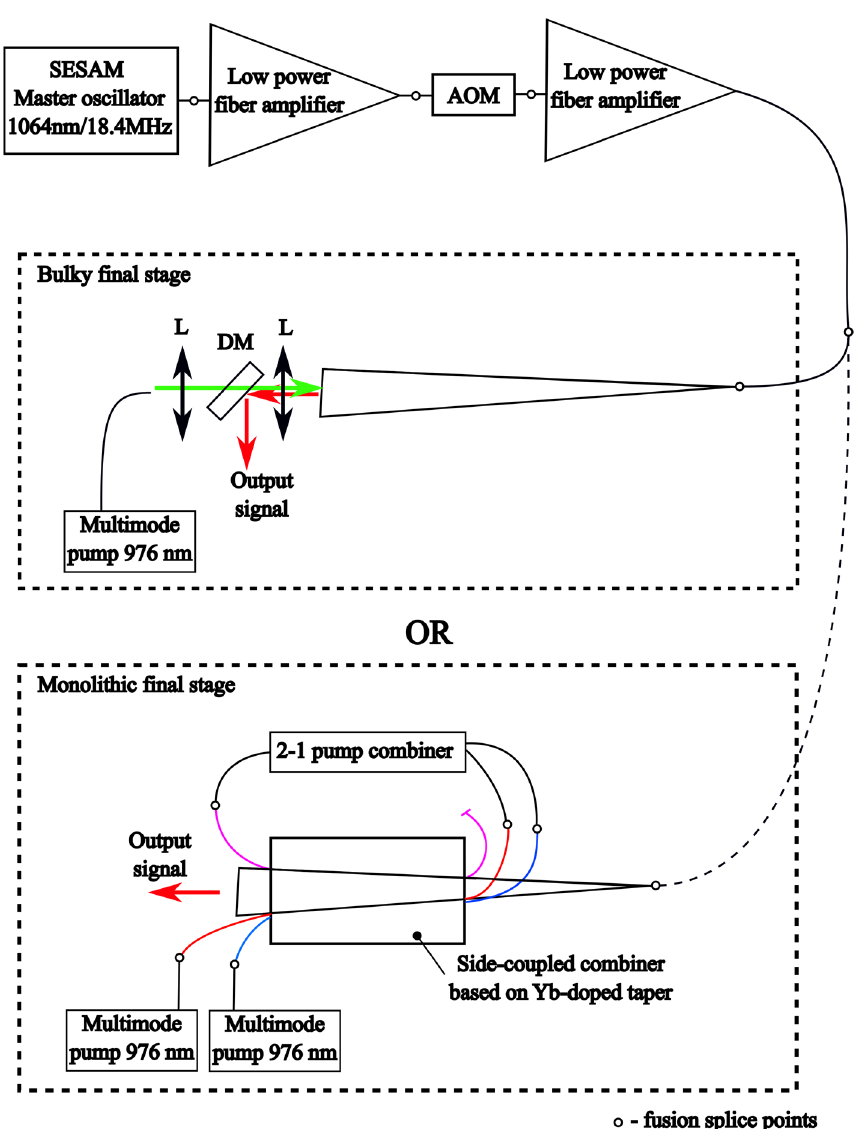
Figure 5. The realized all-fiber MOPA, both bulky and monolithic final stages are shown. Low-power pulses were generated in SESAM master oscillator, amplified at mW level in the low-power fiber amplifiers, and then amplified at 9.1 W level in the bulky or in the monolithic final stage. The green arrow represents the multimode pump radiation, and the red arrow represents the output signal radiation.